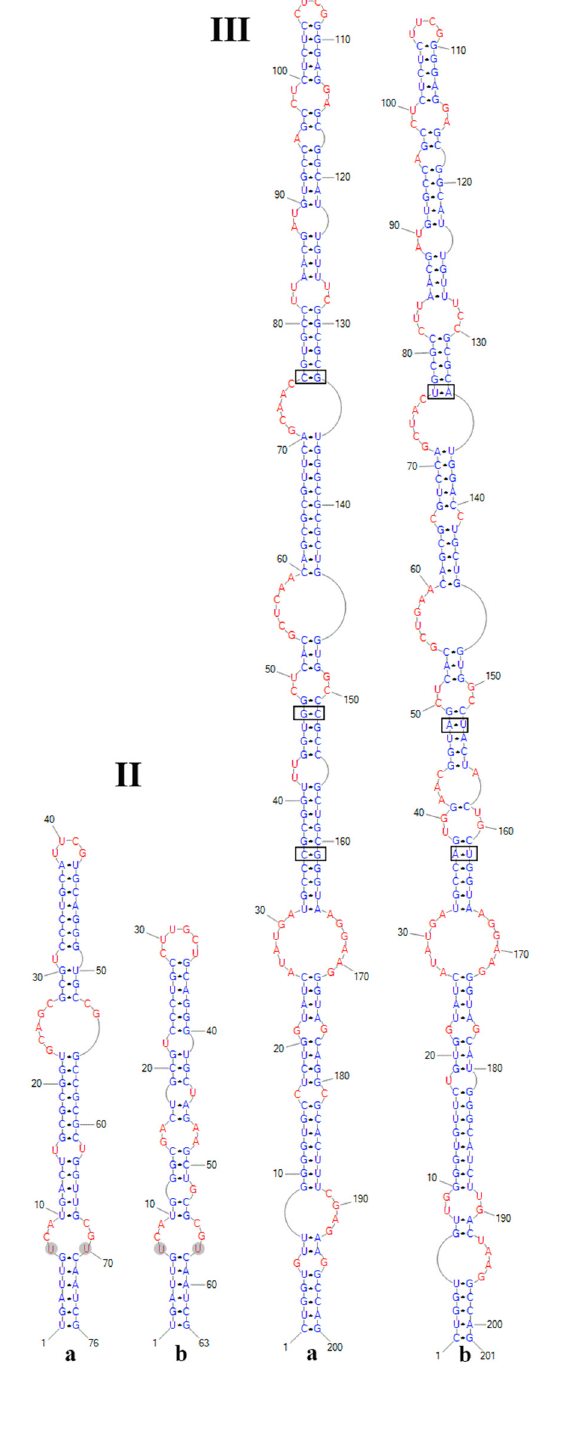
Fig. 15. Predicted secondary structures of the nuclear internal transcribed spacer 2 helix II and helix III (clockwise from 5’ to 3’ termini) of Cryptomonas uralensis Martynenko, Gusev, Kulizin & Guseva sp. nov. ( a , strain UR168) and C. tetrapyrenoidosa Skuja emend. Hoef-Emden & Melkonian ( b , strain M1092, GenBank accession number AJ566146). CBCs are marked by rectangular boxes. In both helices II, the conserved unpaired U-U motif was